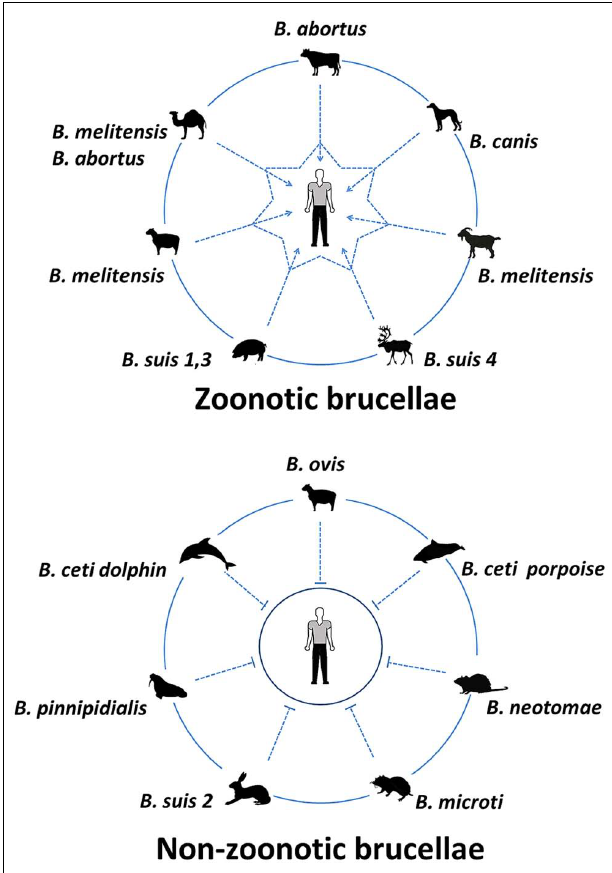
FIGURE 5 | Zoonotic and non-zoonotic Brucella species. The most virulent species with higher zoonotic spectrum are those from domesticated animals; while those displaying lower pathogenicity and zoonotic potential are those from wild life animals. One exception is B. ovis which is a pathogen for rams and does not infect other